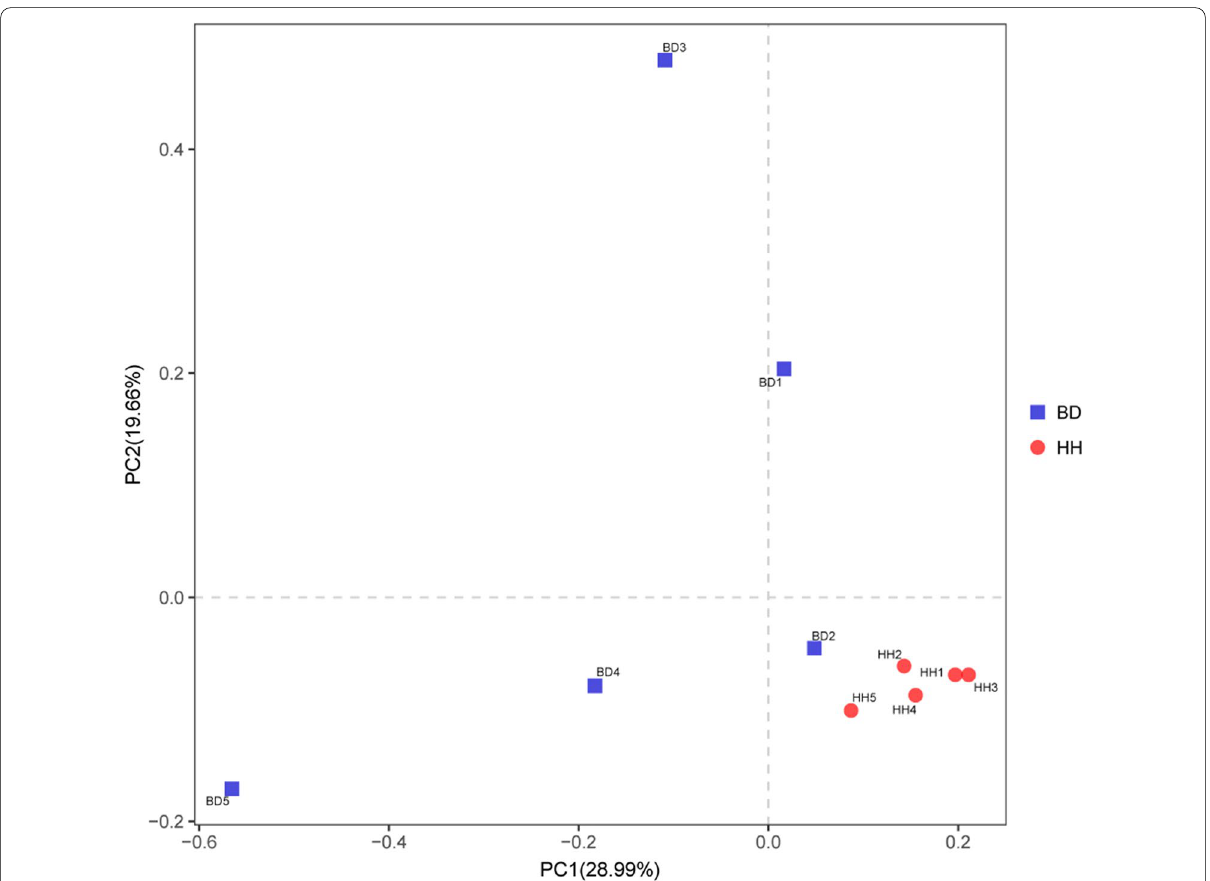
Fig. 1 Comparison of the cecum microbiota by PCoA using the Bray–Curtis similarity index. PCoA principal co-ordinates